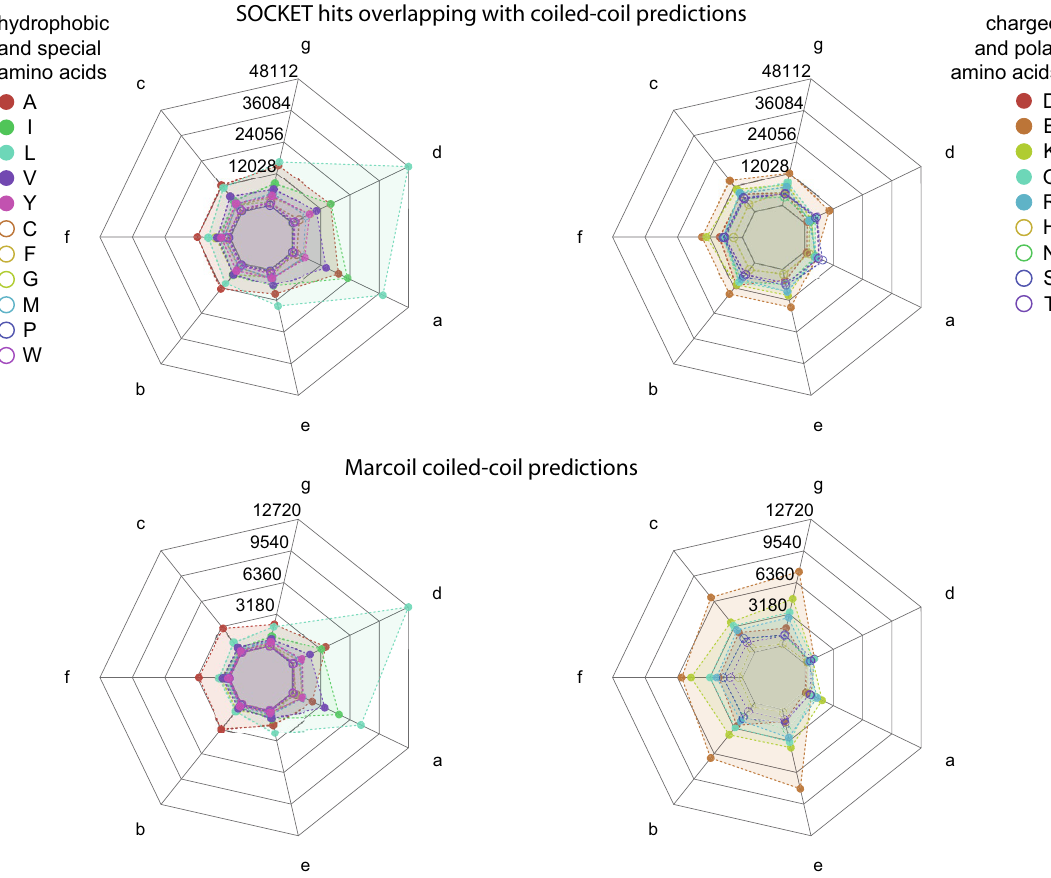
Figure 5. Amino acid preferences at heptad positions abcdefg . The spider plots show the distribution of amino acids at each heptad position. Hydrophobic and special amino acids are shown on the left and hydrophobic and polar amino acids on the right for better orientation. SOCKET not only detects “classical” coiled coils but interacting α-helices within globular protein structures. To reveal possible differences in the amino acid distributions among these two groups, SOCKET hits overlapping (shown here) and not overlapping (Supplementary Fig. S4) coiled-coil predictions were analysed separately. The distribution of hydrophobic and charged amino acids is slightly less biased in the latter structures. Marcoil predictions show strong bias for leucine and isoleucine at the interior positions a and d , and for glutamate at all other positions. The heptad patterns of the other predicted coiled coils show similar distributions. The letters at the axes denote the heptad register positions. Data values at grid lines refer to amino acid counts at each heptad position over all heptads. Amino acids with high proportions are shown as filled circles and amino acids with low proportions as unfilled